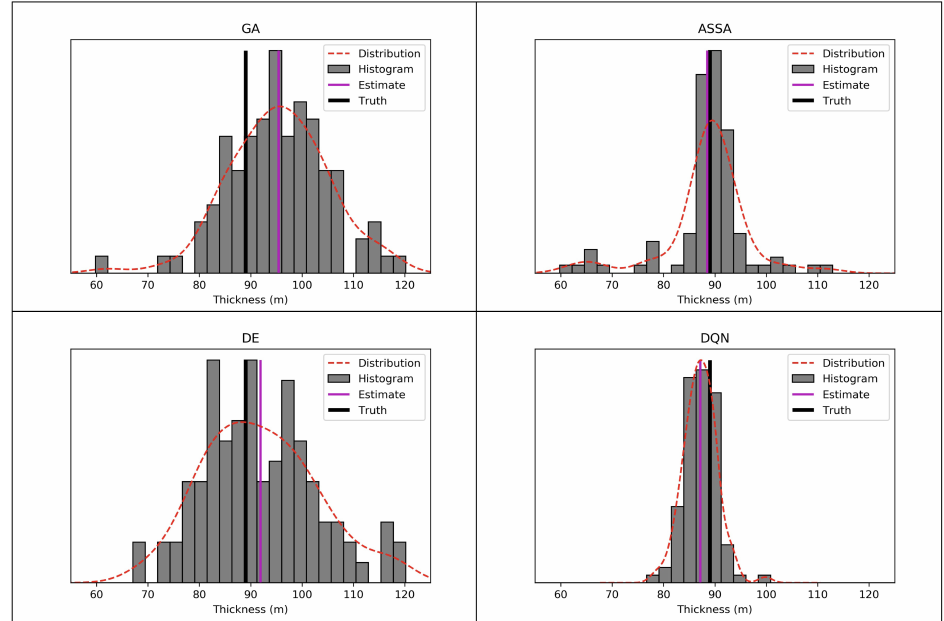
Figure 6. Statistic analysis of h 2 over the candidate